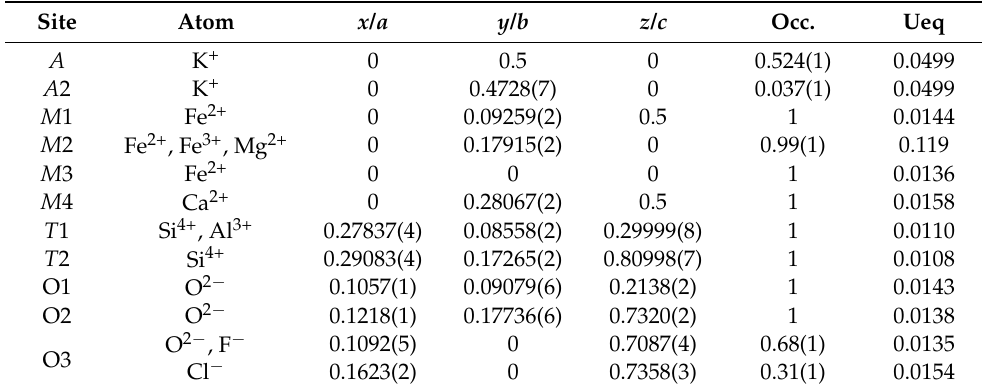
Table 6. Crystallographic coordinates, occupancies, and equivalent/isotropic atomic displacement parameters (Å 2 ) of the studied potassic-hastingsite